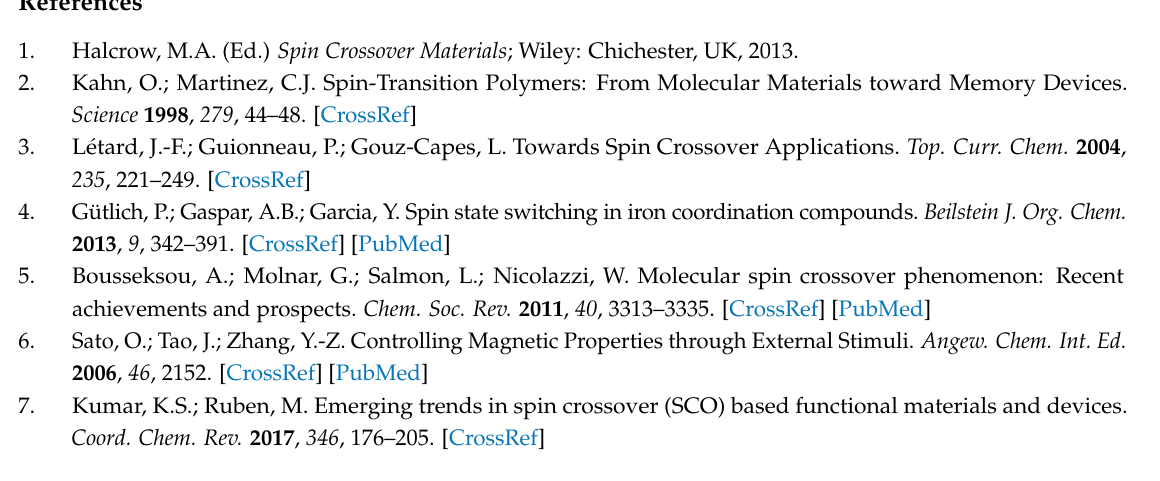
Table S8: Cartesian coordinates of DFT-optimized hs-[Fe(tren)py 3 ] 2+ , Table S9: Cartesian coordinates of DFT-optimized [Zn(tren)py 3 ] 2+